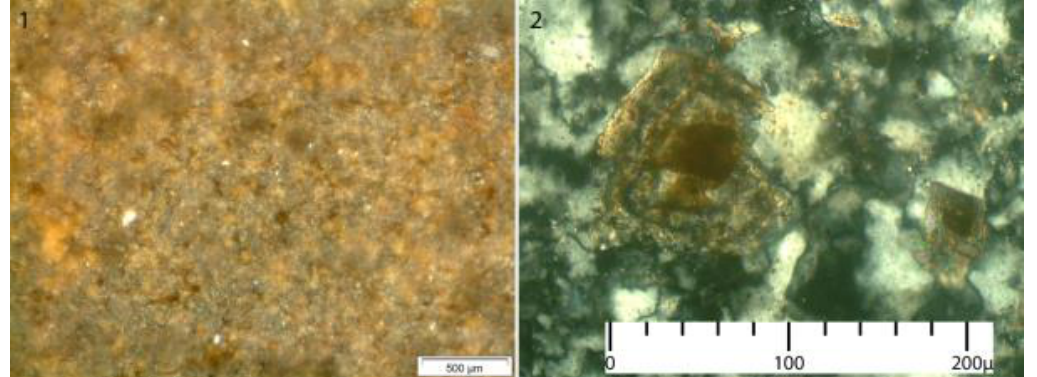
Figure 6. Oxfordian flints’ macro and microscopic textures and constituents; Genetic Type J3-2: 1. General texture (scale bar = 500 µm); 2. Dolomite or calcite rhombohedra undergoing silicification (scale bar = 200 Journal of Lithic Studies (2016) vol. 3, nr. 2, p. 541-560 doi:10.2218/jls.v3i2.1452